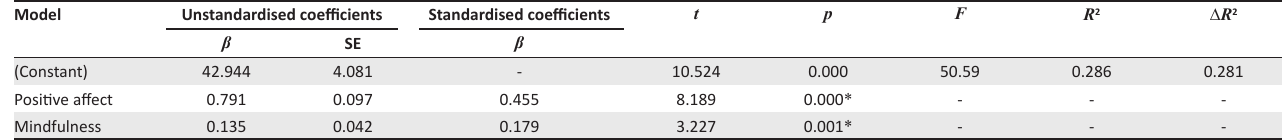
TABLE 3: Multiple regression with resilience being the dependent variable, and positive affect and mindfulness being the independent variables.